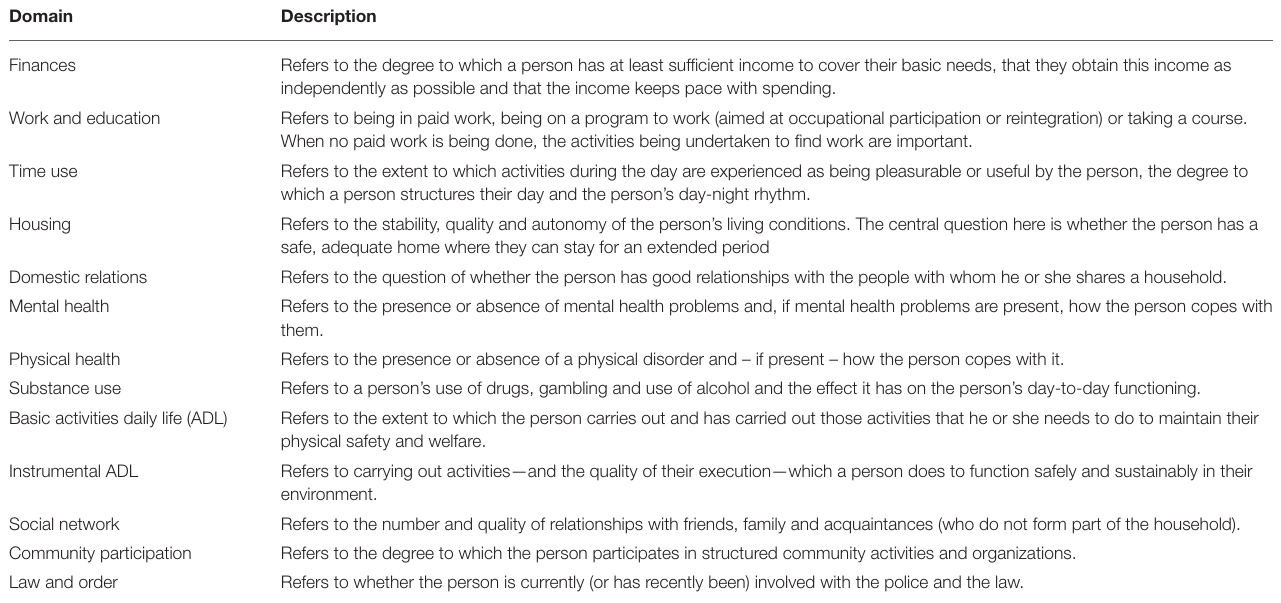
TABLE 1 | Description of SSM-D domains.